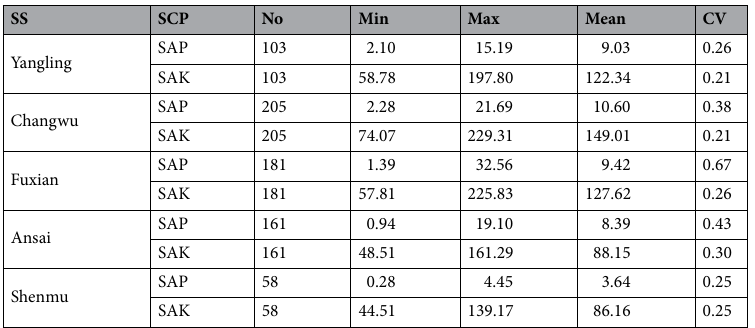
Table 1. Descriptive statistics for the soil available phosphorus (SAP) and soil available potassium (SAK) concentrations at different sampling sites. SS sampling site, SCP soil chemical property, No. Number, Min minimum, Max maximum, CV coefficient of variation, SAP soil available phosphorus, SAK soil available potassium.